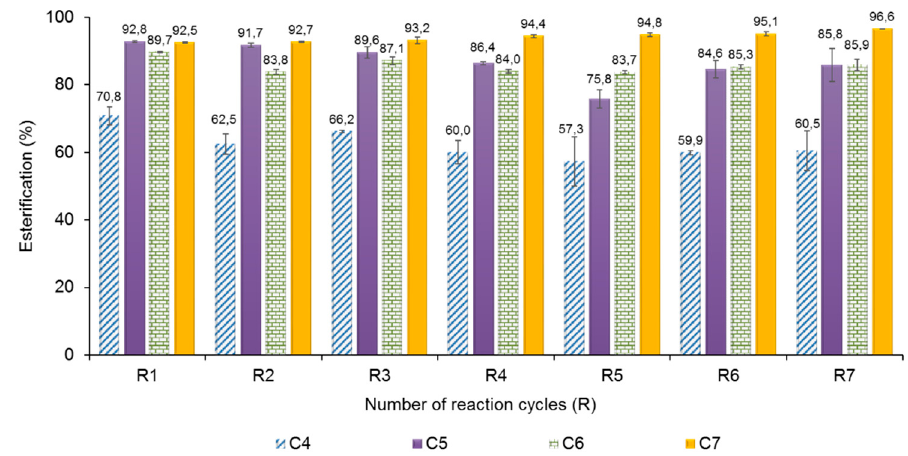
Figure 5. Operational stability of the catalyst AMNP-GA-OPEr, across seven cycles of esterification with 500 mM of 1-butanol and 250 mM of each VFA. Reactions were performed in isooctane, at 25 °C and 100 rpm with 11 U of the catalyst added in the first reaction cycle.